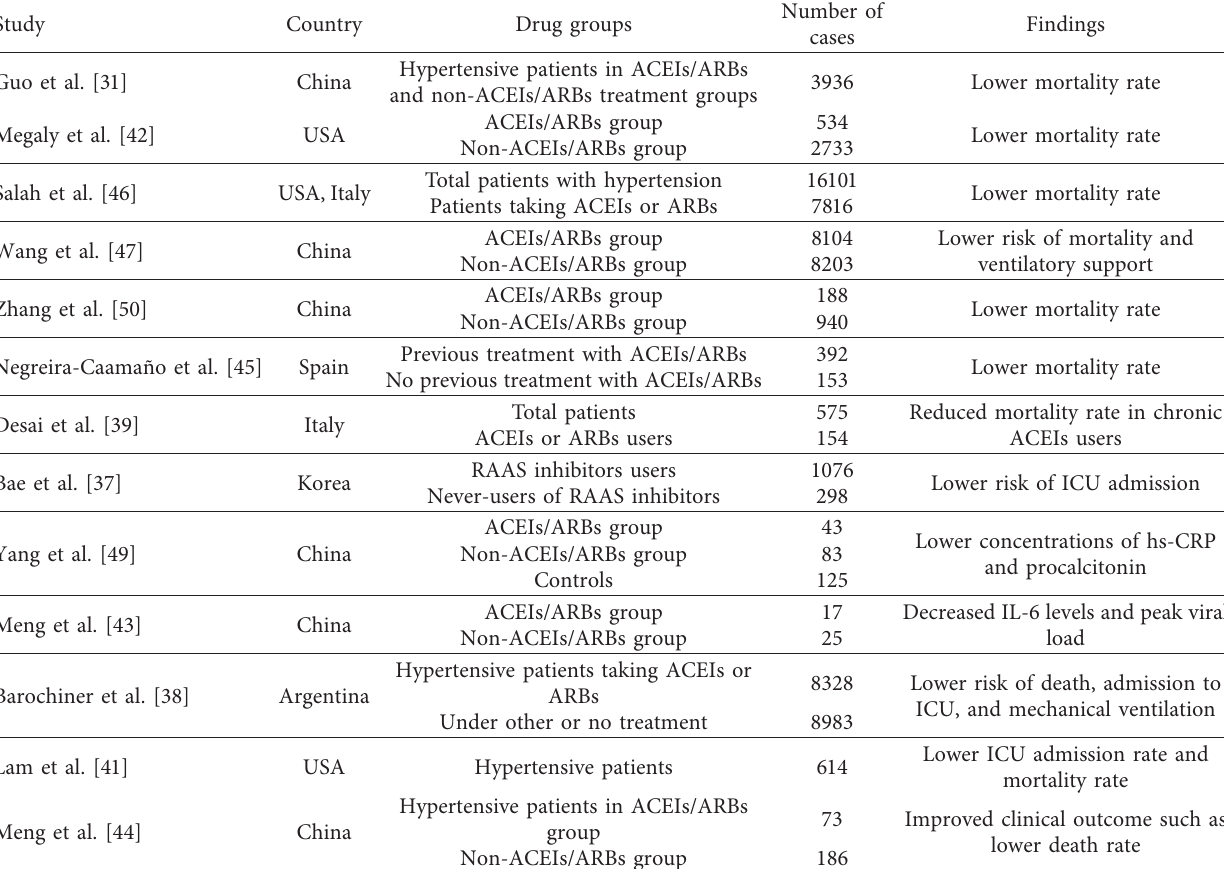
Table 2: Studies that showed beneficial effects of ACEIs/ARBs on COVID-19 in hypertensive patients.